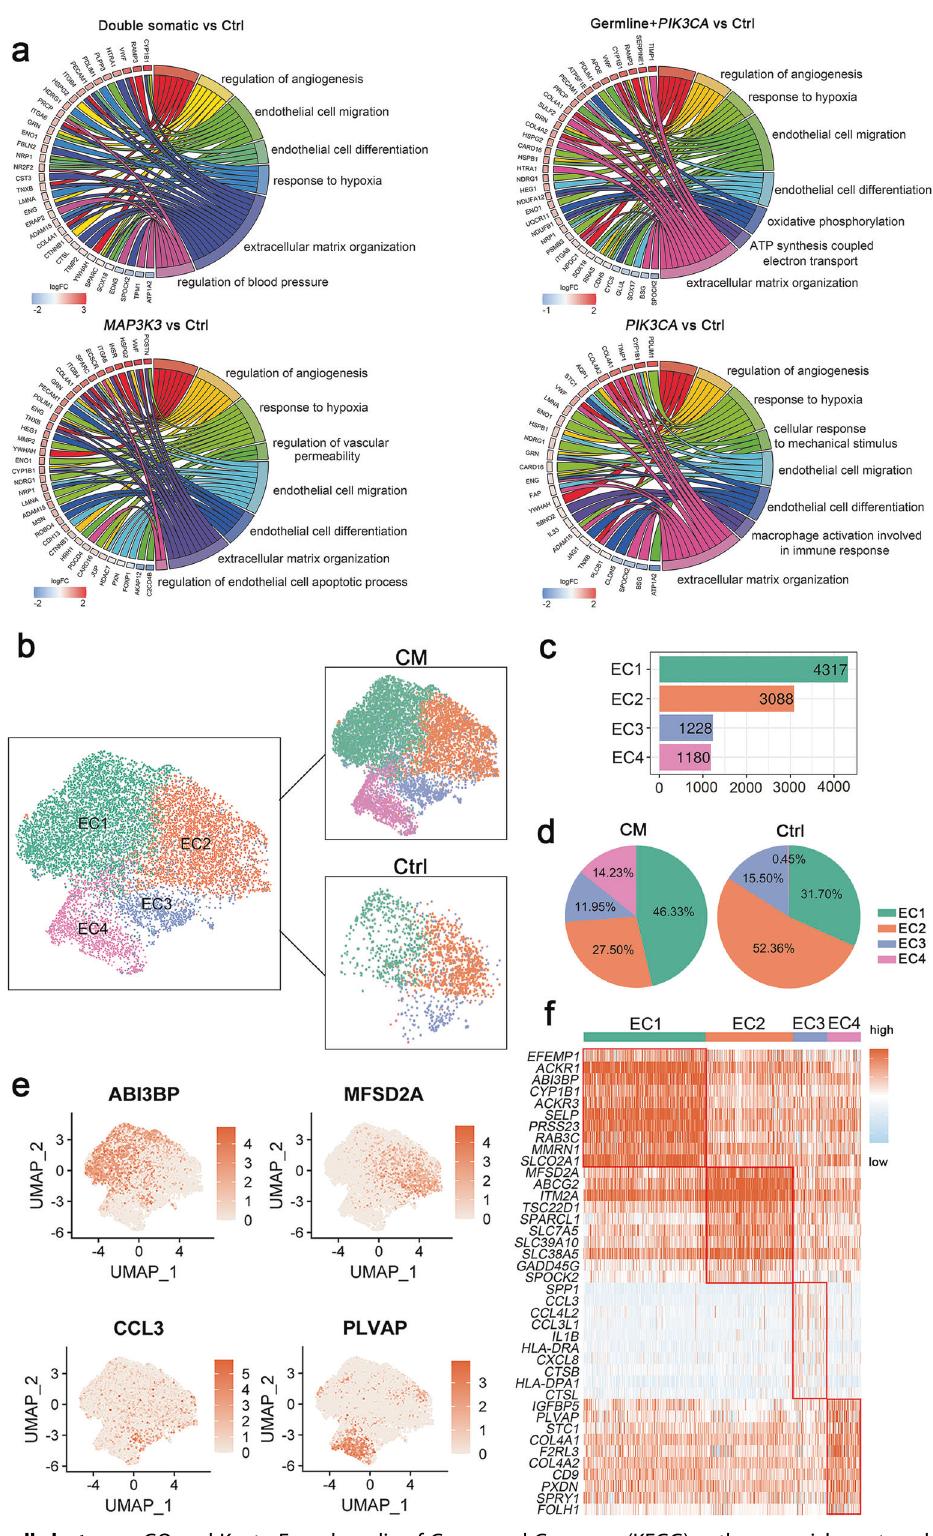
Fig. 2 Endothelial cell clusters. a GO and Kyoto Encyclopedia of Genes and Genomes (KEGG) pathway enrichment analyses of differentially expressed genes (DEGs) in ECs between CM samples with different genetic mutations and control samples, shown in chord plots. b UMAP plot for the distributions of four EC subclusters in control and CM samples. CM, twelve CM samples; Ctrl, three control samples. c Cell numbers of four EC subclusters. d Pie plots for the cell number percentages of four EC subclusters in the control and CM groups. e Marker genes of four EC subclusters shown with UMAP plots. f Top ten differentially expressed genes (DEGs) in four EC